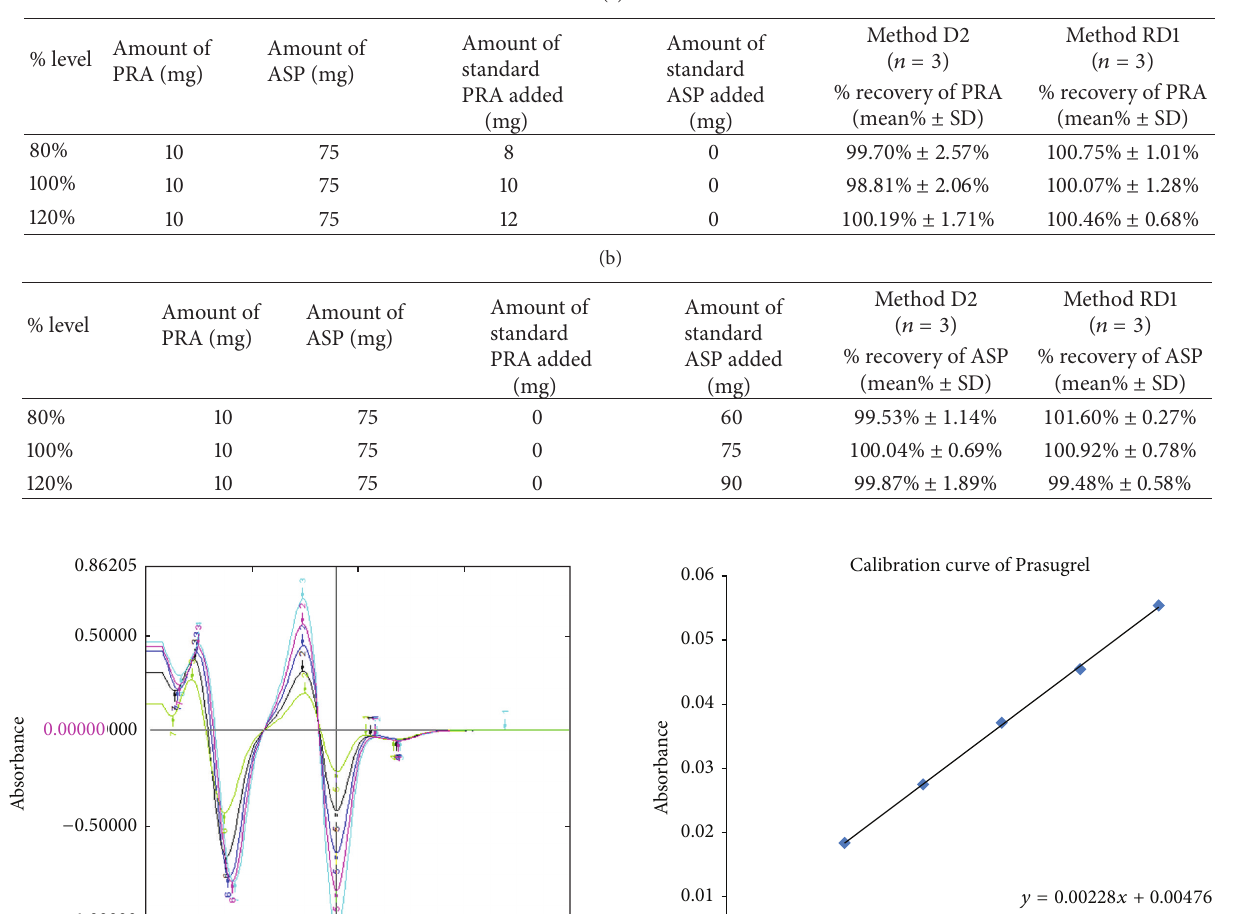
Table 3: (a) Recovery studies for Prasugrel. (b) Recovery studies for Aspirin. (a)